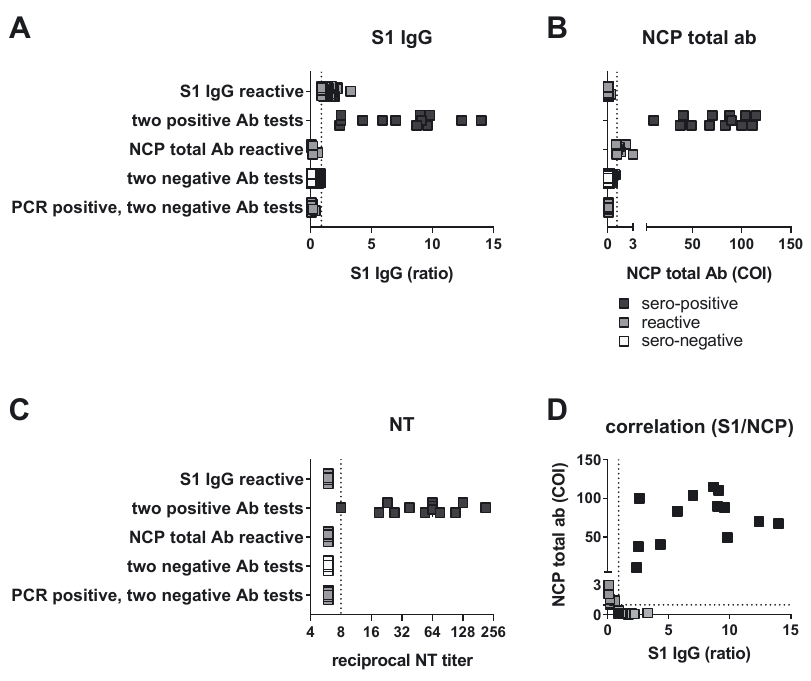
Figure 2: Identification of sero-positive participants. (A) Test results in Euroimmun S1 IgG ELISA and (B) Roche NCP total Ab CLIA from 82 sera reactive in S1 ELISA only, 13 sera with two positive Ab tests, seven sera only reactive for NCP total Ab CLIA, 3,524 sera with two negative test results and seven sera from PCR-positive but antibody- negative participants. (C) Reciprocalgeometric mean neutralization titers against SARS-CoV-2 in cell culture from six sera reactive in S1 ELISA only, 13 sera with two positive Ab tests, five sera only reactive for NCP total Ab CLIA, six representative sera with two negative test results and